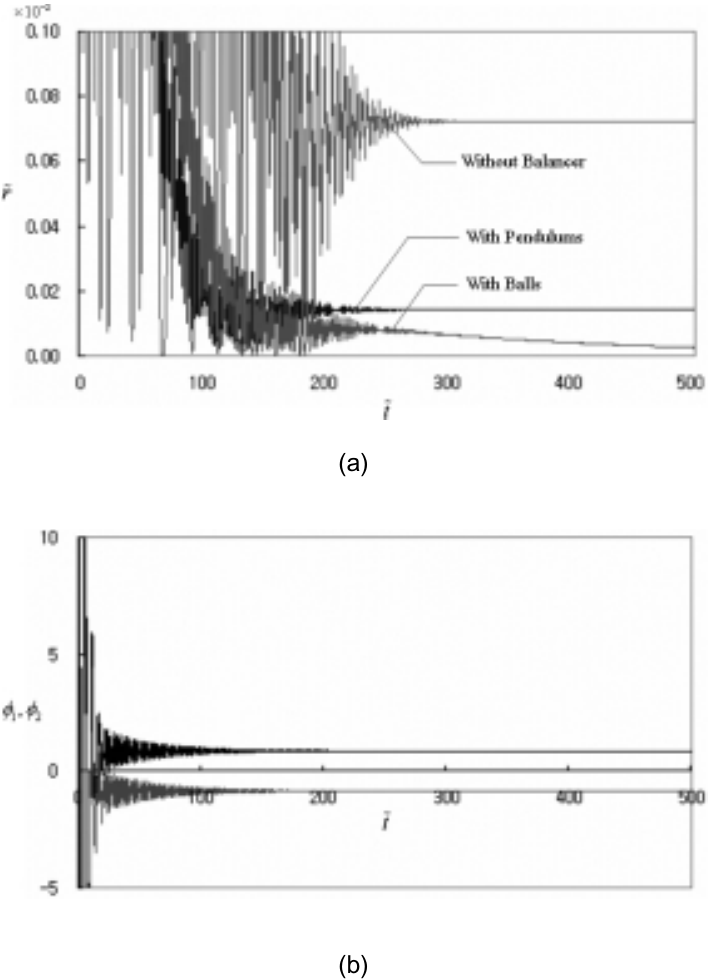
Fig. 9. Time response of system with Pendulum or Ball Automatic Dynamic Balancer for ˜ ω = 2 . 5 and ˜ m = 0 . 116 . (a) Time response of the radial displacement. (b) Time response of the pendulum